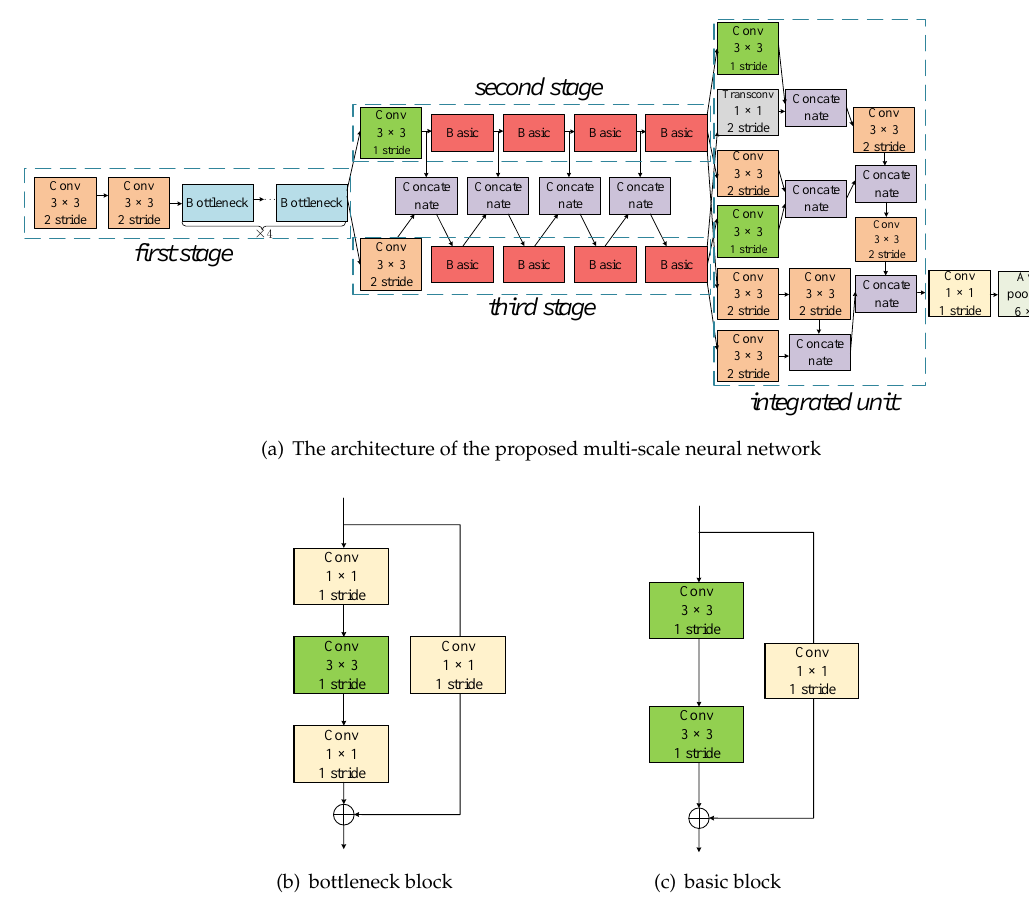
Figure 4. Feature maps in different resolution. ( a , d ) The original remote sensing images. ( b , e ) The high-resolution feature maps that contain the outlines and corner points information of images. ( c , f ) The low-resolution feature maps that contain the semantic information of images.